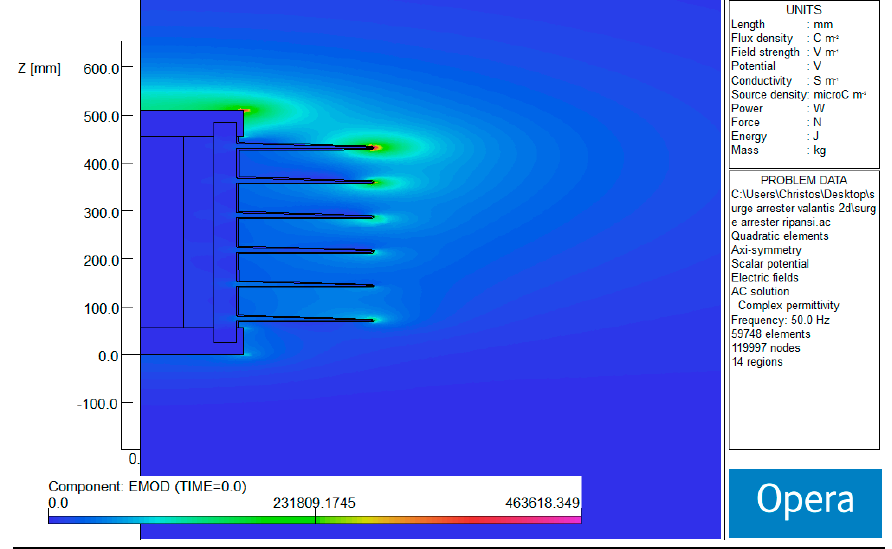
Figure 11. Electric field around the arrester in the case of pollution on the surface of the external insulation (2D PC Opera).